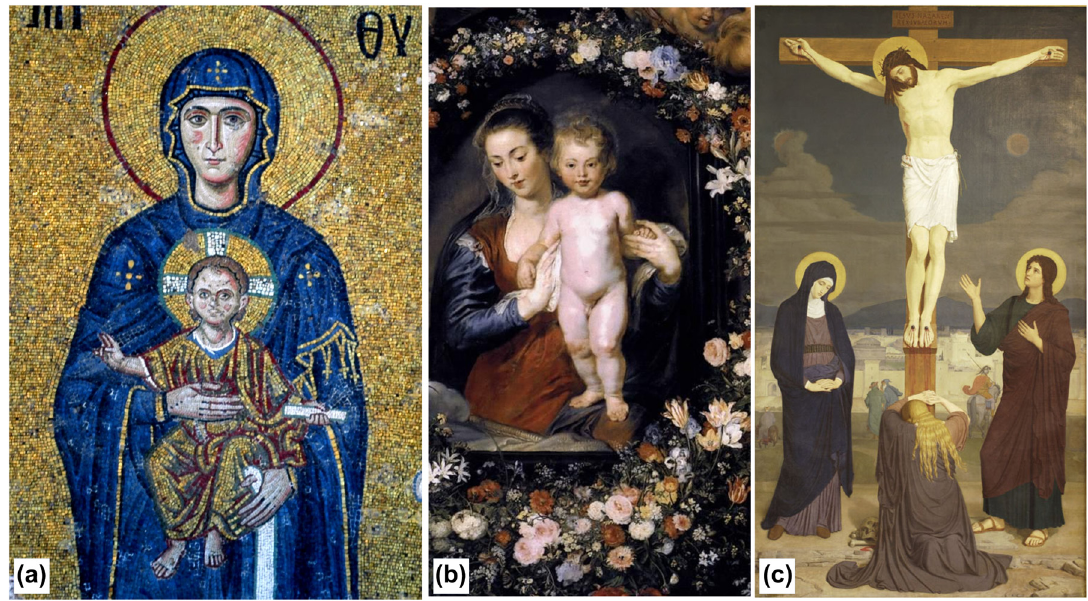
Figure 4: Representation of the Virgin Mary with the baby (a and b), [25, 26] and in the Stabat Mater (c, [27]). In all images Mary is dressed with blue colors, which make her immediately recognizable, also among the other figures (Magdalena and St. John) under the cross in